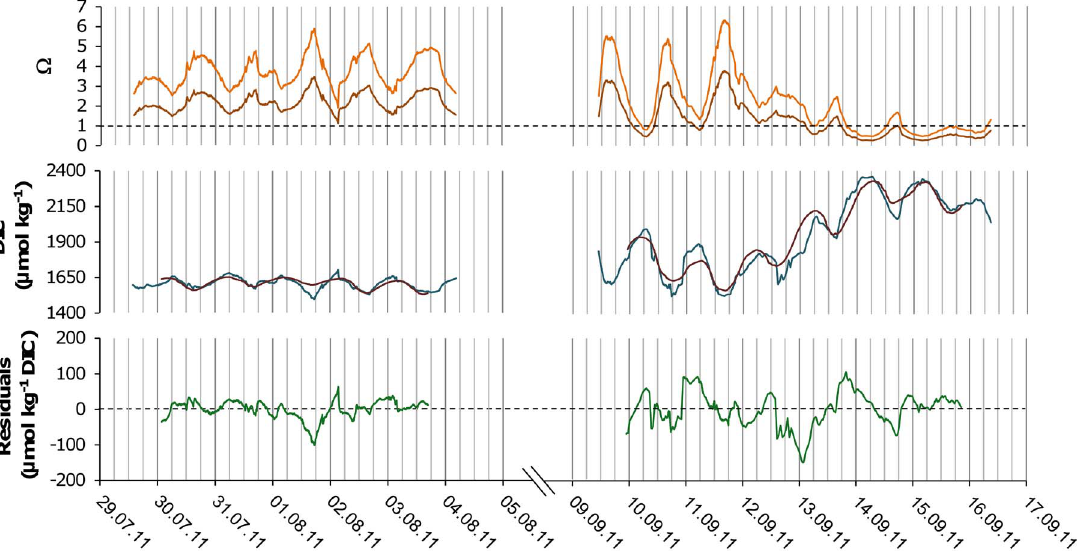
Figure 4. Calculated and modeled carbonate chemistry. Top panels: Saturation states for calcite (light brown) and aragonite (dark brown) for August (left) and September (right). Dashed line: Saturation threshold. Central panels: Observed (cyan) and modeled (red) DIC for August (left) and September (right). The residuals between model and observations are presented in bottom left and right for August and September respectively. Secondary vertical gridlines unit: 6